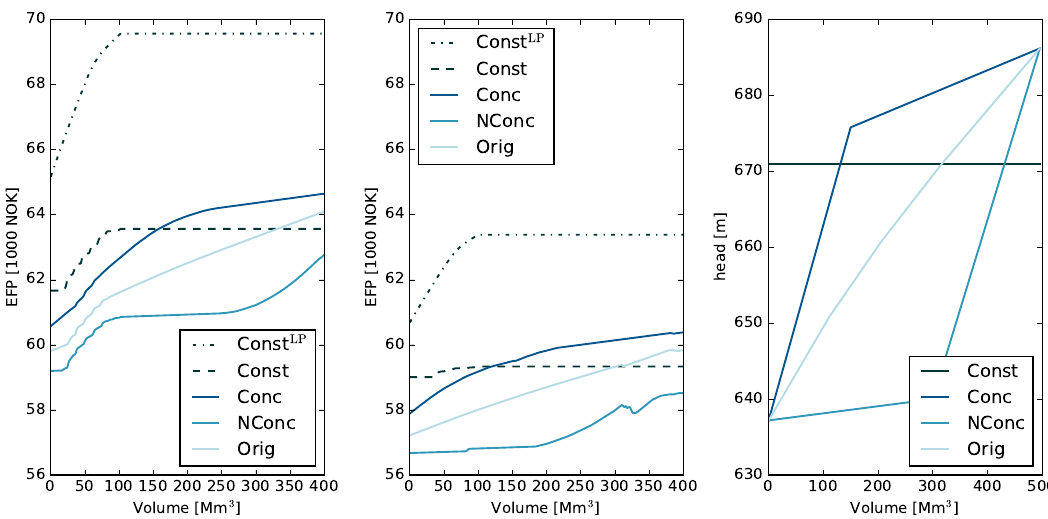
Figure 3. ( Left ) EFP with sales of reserve capacity and energy. ( Middle ) EFP with sales of energy. ( Right ) Different head functions. The colors of the lines in the two leftmost figures refer to the head function, h ( V ) , in the right figure. The different head functions are constant (Const), concave (Conc), original (Orig) and nonconcave (NConc), respectively. The Const LP function refers to the linear programming relaxation of the MTHS problem. Both dashed lines refer to the constant head function; thus, the power output only depends on